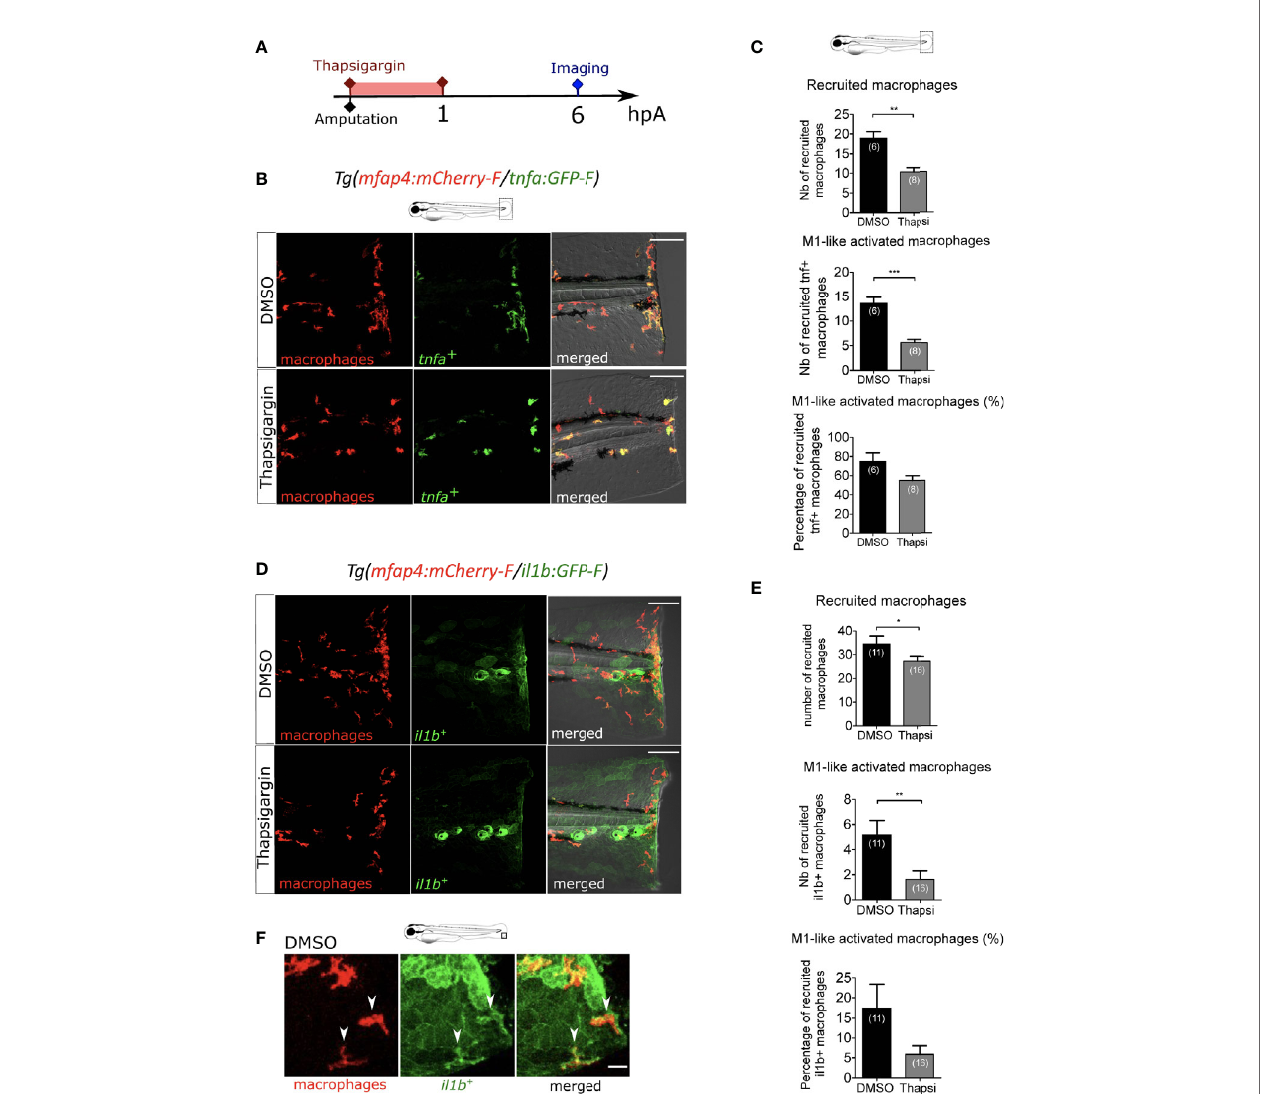
FIGURE 2 | Intracellular Ca 2+ signaling mediates macrophage recruitment and activation. (A) Schedule of the experiment. Immediately after the fi n fold amputation at 3 dpf, Tg(mfap4:mCherry-F/tnfa:GFP-F) or Tg(mfap4:mCherry/il1b:GFP) larvae were treated with Thapsigargin or DMSO for 1 h. Thapsigargin was removed and larvae were imaged at 6 hours post amputation (hpA) using confocal microscopy. (B) Tail images are representative maximum projections of the fl uorescence of mCherry-F (macrophages), GFP-F ( tnfa + cells) and merged channel images of Tg(mfap4:mCherry-F/tnfa:GFP-F) injured larvae, after the treatment with DMSO (up) or Thapsigargin (down) at 6 hpA. Scale bars: 100 m m. (C) Quanti fi cation of recruited macrophages (up) and tnfa + recruited macrophages (middle) after the DMSO and Thapsigargin treatments at 6 hpA. The lower graph represents the percentage of tnfa + macrophages in the recruited population. Representative experiment of three independent experiments, mean ± SEM, n larvae is indicated in brackets, Mann Whitney test, two-tailed, **p<0.01, ***p<0.001. (D) Tail images are representative maximum projections of the fl uorescence of mCherry-F (macrophages), GFP-F ( il1b + cells) and merged channel images with bright fi eld of Tg(mfap4:mCherry/il1b: GFP) injured larvae after the treatment with DMSO (up) or Thapsigargin (down) at 6 hpA. Scale bars: 100 m m. (E) Quanti fi cation of recruited macrophages (up) and il1b + recruited macrophages (middle) after the DMSO and Thapsigargin treatments at 6 hpA. The lower graph represents the percentage of il1b + macrophages in the recruited population. Two independent experiments merged, mean ± SEM, n larvae is indicated in brackets, one-tailed t-test with Welch ’ s correction, *p<0.05, **p<0.01. (F) Representative zoomed maximum projections of the fl uorescence of mCherry-F (macrophages) and GFP-F ( il1b + cells) merge channels images in injured fi n fold of Tg(mfap4:mCherry/il1b:GFP) at 6hpA after the treatment with DMSO. Arrow heads show the overlap between GFP and mCherry signal in macrophages. Scale bar: 20 m